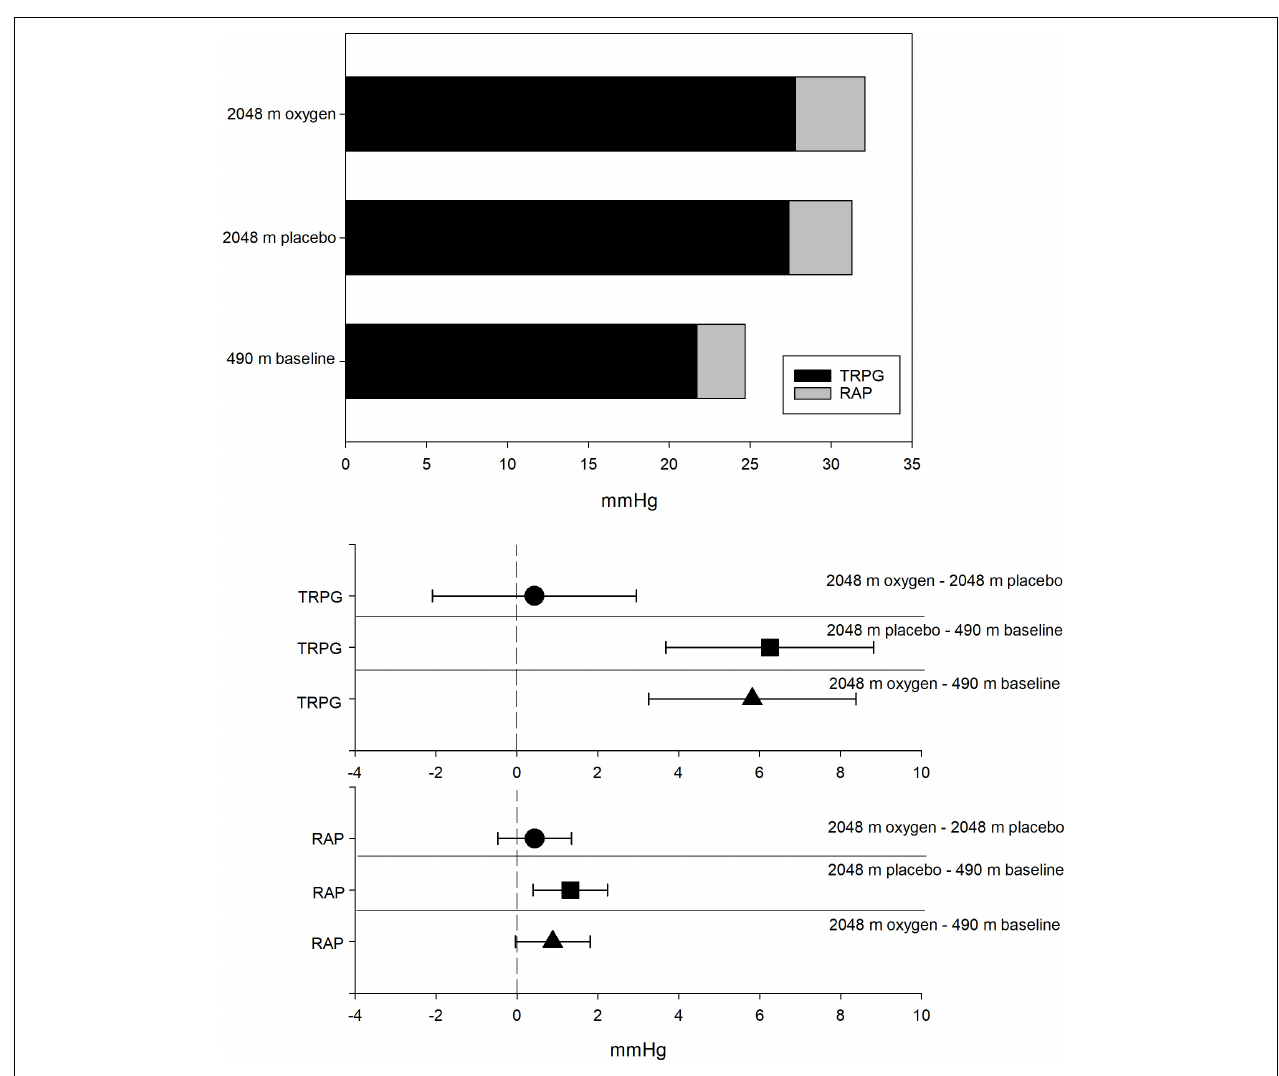
FIGURE 2 | Systolic pulmonary artery pressure displayed as sum of the tricuspid regurgitation pressure gradient (TRPG) and the right atrial pressure (RAP) at 490 and 2,048 m [with placebo and nocturnal oxygen therapy (NOT), respectively]. The lower part shows the differences of the TRPG and the RAP for oxygen, 2,048 m placebo; (cid:4) , 2,048 m placebo, 490 m baseline; and (cid:78) , 2,048 m oxygen, 490 m